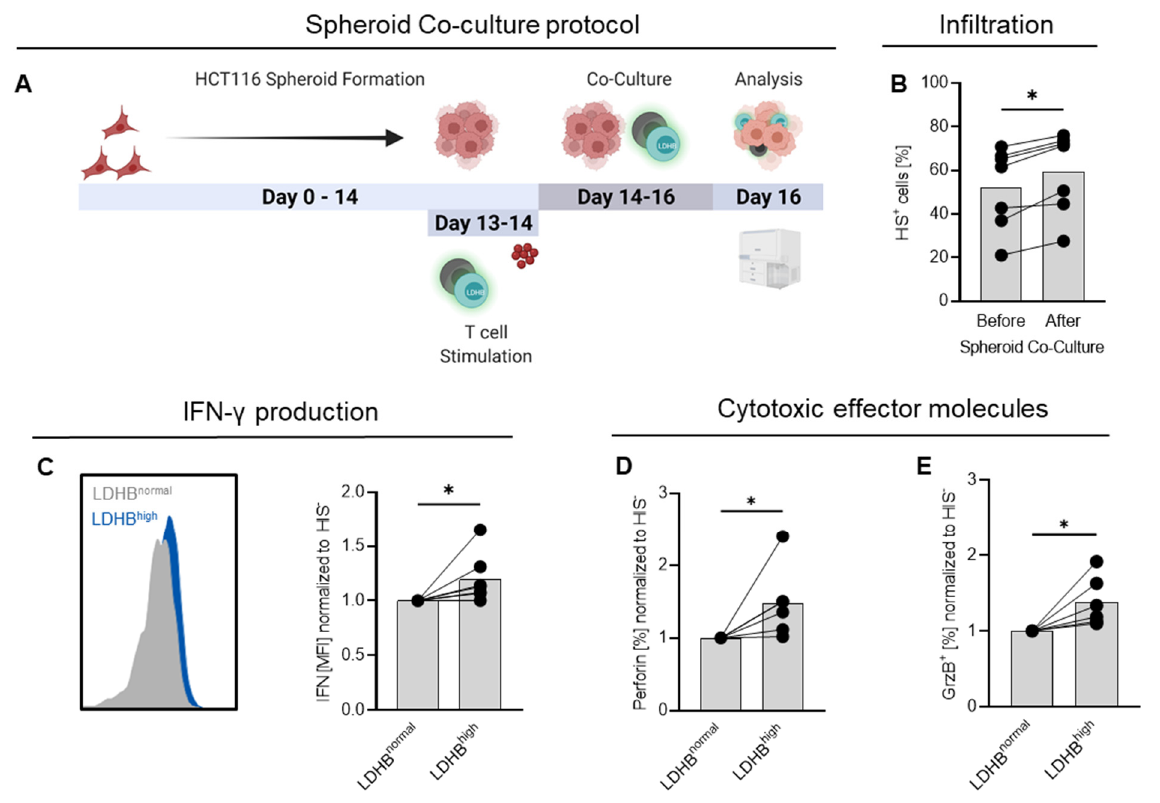
Figure 5. LDHB-overexpressing CD4 T cells show improved infiltration and higher expression of cytotoxic effector molecules in HCT116 spheroid co-cultures. ( A ) Schematic depiction of the co-culture protocol. Graphic created with BioRender.com. ( B ) Percentage of LDHB high cells was assessed by flow cytometry before addition to spheroids and after co-culture among infiltrated T cells. ( C – E ) After 48 h co-culture, monensin was added to spheroid co-cultures. After 3 h, single cell suspensions were generated from co-cultures and T cells analyzed for their expression of ( C ) IFN, ( D ) Perforin and ( E ) Granzyme B (GrzB). The HIS-Tag was used for identification of LDHB overexpressing cells. For analysis, ( C ) median fluorescence intensity (MFI) and ( D , E ) percentage of positive cells measured among LDHB high cells were normalized on LDHB normal cells. ( B – E ) Shown are median levels and single data points. Lines connect paired data. Statistical significance was calculated using Wilcoxon’s matched pair signed rank test (* p < 0.05).